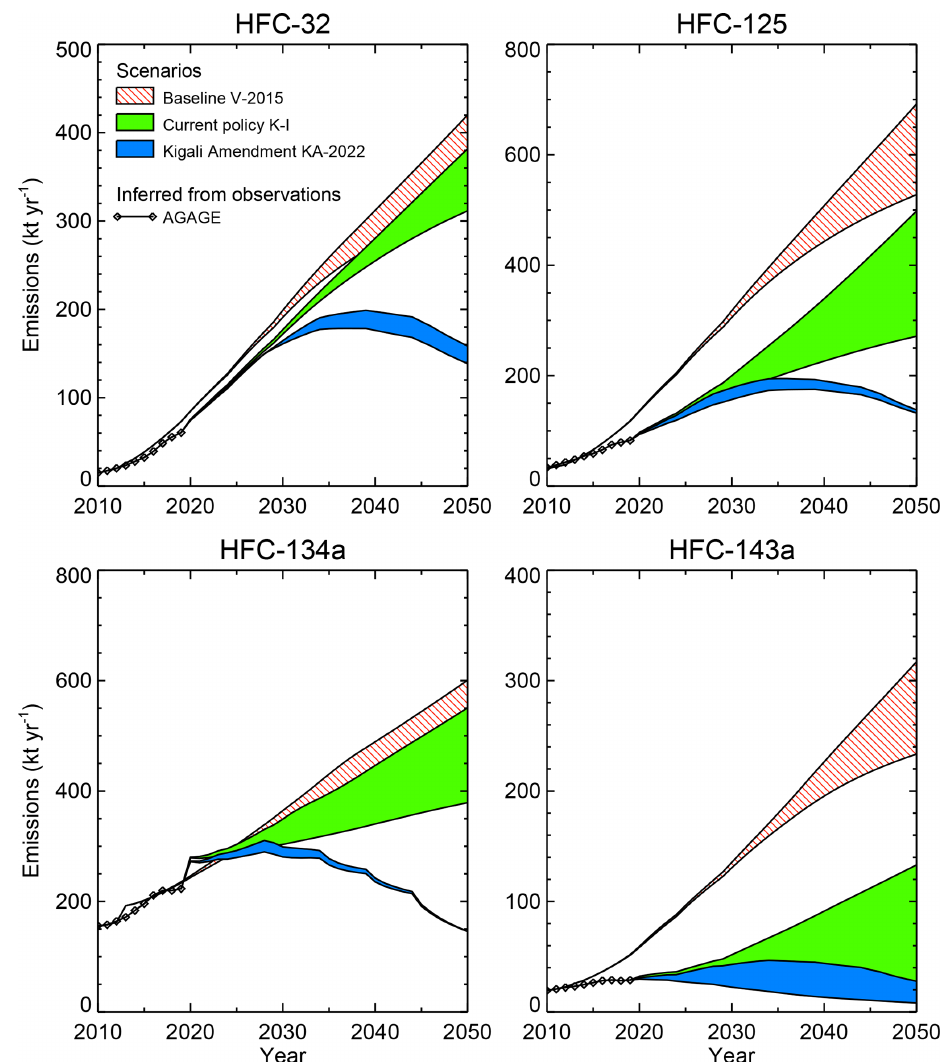
Figure 5. Global total emissions (ktyr − 1 ) of HFC-32, HFC-125, HFC-134a, and HFC-143a from the V-2015 baseline scenario, the current policy K-I scenario, and the Kigali Amendment (KA-2022) scenario. The bands represent the upper and lower ranges of these scenarios. Also shown are the emissions inferred from observed mixing ratios from the AGAGE